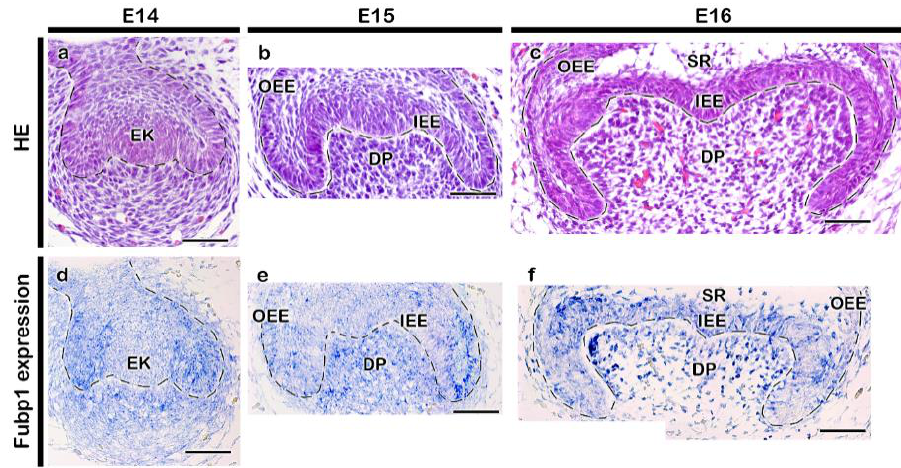
Figure 1. Expression of Fubp1 in developing tooth. H&E staining of developing tooth ( a – c ) and section in situ hybridization of Fubp1 at E14-E16 ( d – f ). At E14 and E15, Fubp1 is expressed broadly at epithelium and mesenchyme. At E16, Fubp1 is expressed in IEE and DP, however, more intense expression is observed in IEE. The dotted lines demarcate the boundary of tooth epithelium ( a – f ). EK, enamel knot; IEE, inner enamel epithelium; OEE, outer enamel epithelium; SR, stellate reticulum; DP, dental papilla. Scale bars: 50 µ m ( a – f